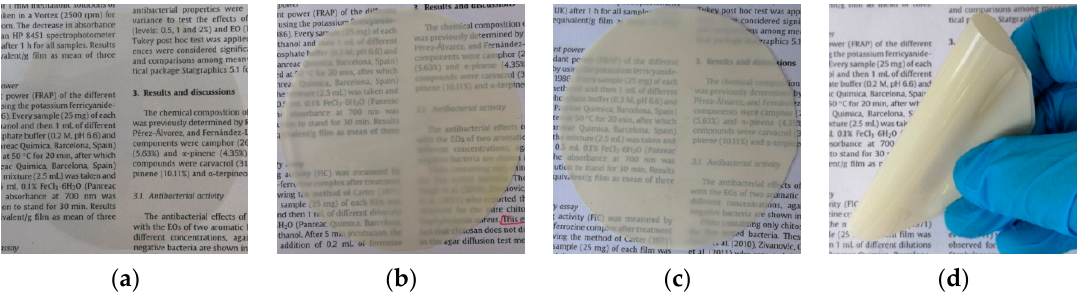
Figure 4. Appearance of different films. ( a ) Control; ( b ) 3% TiO 2 -N; and ( c , d ) 9% CO-3% TiO 2 -N.